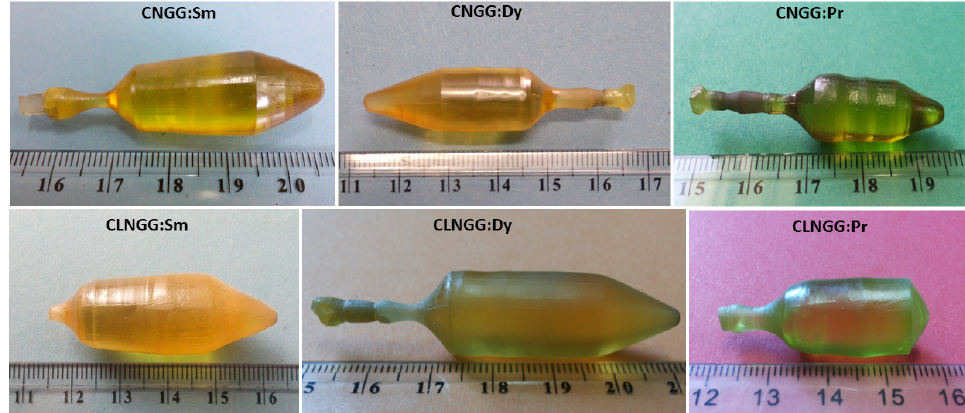
Figure 1. CNGG:RE and CLNGG:RE (RE = Sm, Dy, and Pr) obtained crystals. (Reprinted with per- mission from Ref. [47], copyright 2018,